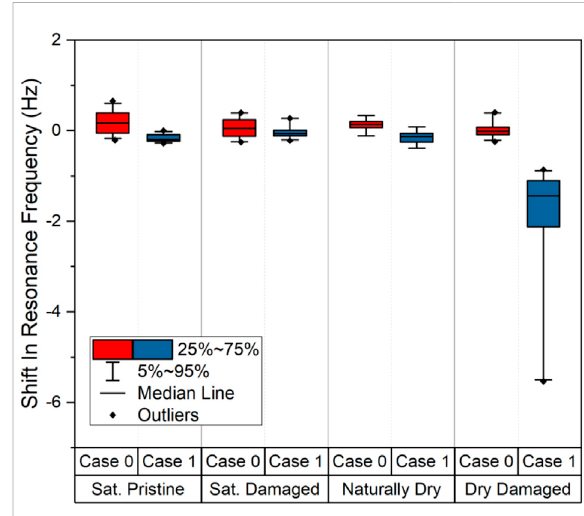
FIGURE 13 Sequential impact test results of the fundamental transverse resonant frequency shift during one series of impacts in neat cementpastesamplesfortheuniformsaturatedpristinecondition, Case 0 (red), and then the same sample after damage and/or environmental exposure, Case 1 (blue), for four different test conditions. The height of the solid bar represents the 50% percentile con fi dence interval for fi ve separate prisms of each grouptestedfourtimeseachcase.Case0representsthesaturated pristine material condition before exposure to the subject